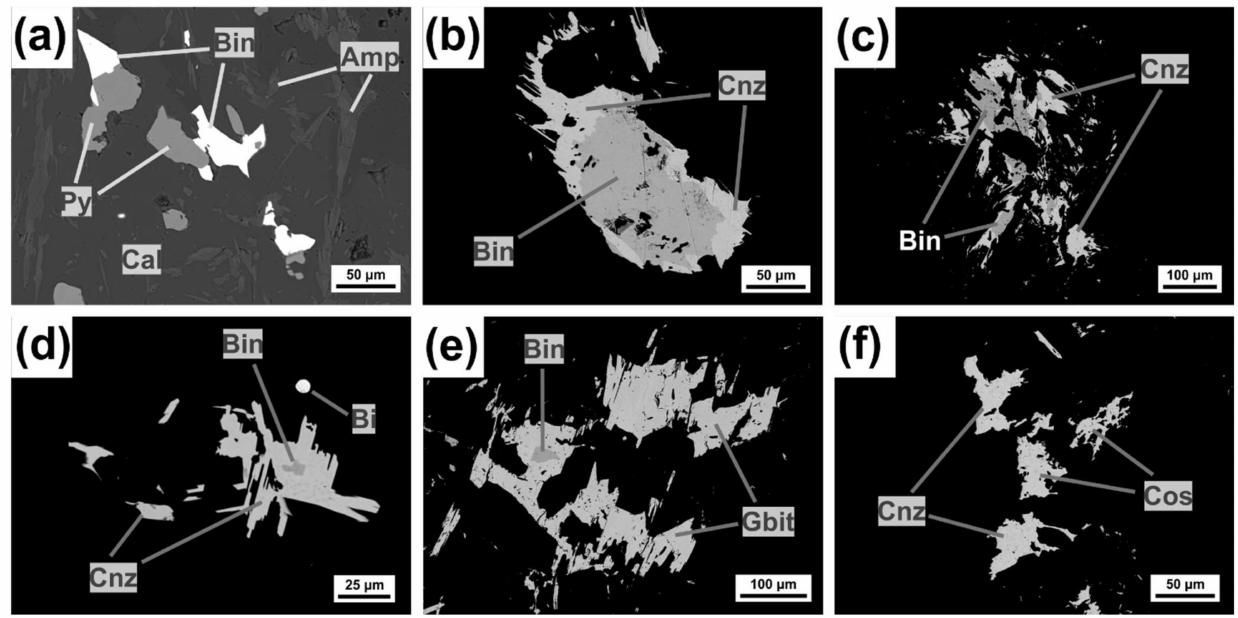
Figure 15. Formation stages and paragenetic sequence of Bi-Au-Cu-Te mineralization from the Kizhnica hornfels.